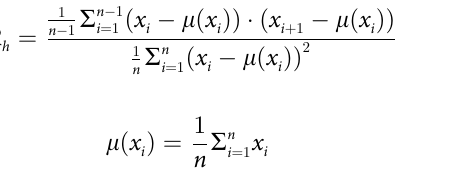
ffiffiffiffiffiffiffiffiffiffiffi p n (cid:2) 2 Þ = ð n (cid:2) 1 Þ ð 11 Þ